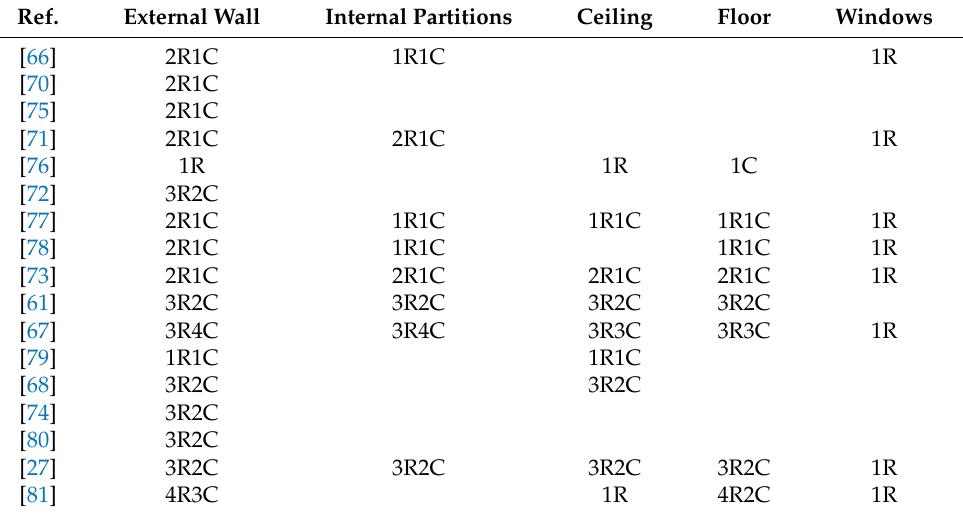
Table 3. Thermal network configurations for building construction